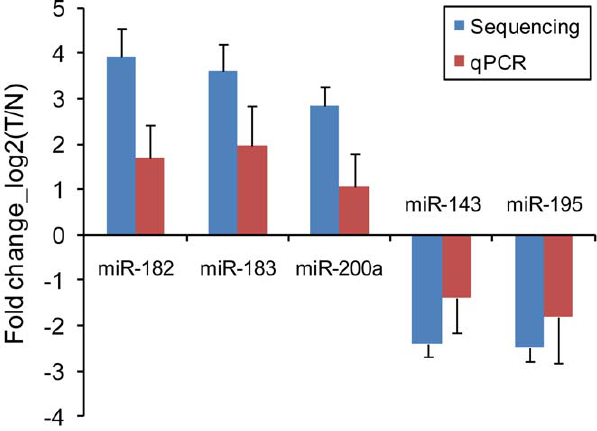
Figure 1. The comparison between deep sequencing data and Real-Time qPCR results. For the comparison between deep sequencing data and Real-Time qPCR results, hsa-miR-182 , hsa-miR- 183 , hsa-miR-200a , hsa-miR-143 and hsa-miR-195 determined to be differentially expressed in bladder urothelial carcinoma compared to matched histologically normal urothelium in nine patients by deep sequencing were validated using Real-Time qPCR. The heights of the columns in the chart represent the log-transformed median fold changes (tumor/normal) in expression across the nine patients for each of the five miRNAs validated; the bars represent standard errors. The validation results of the five miRNAs indicated that the deep sequencing data correlated well with the Real-Time qPCR results.